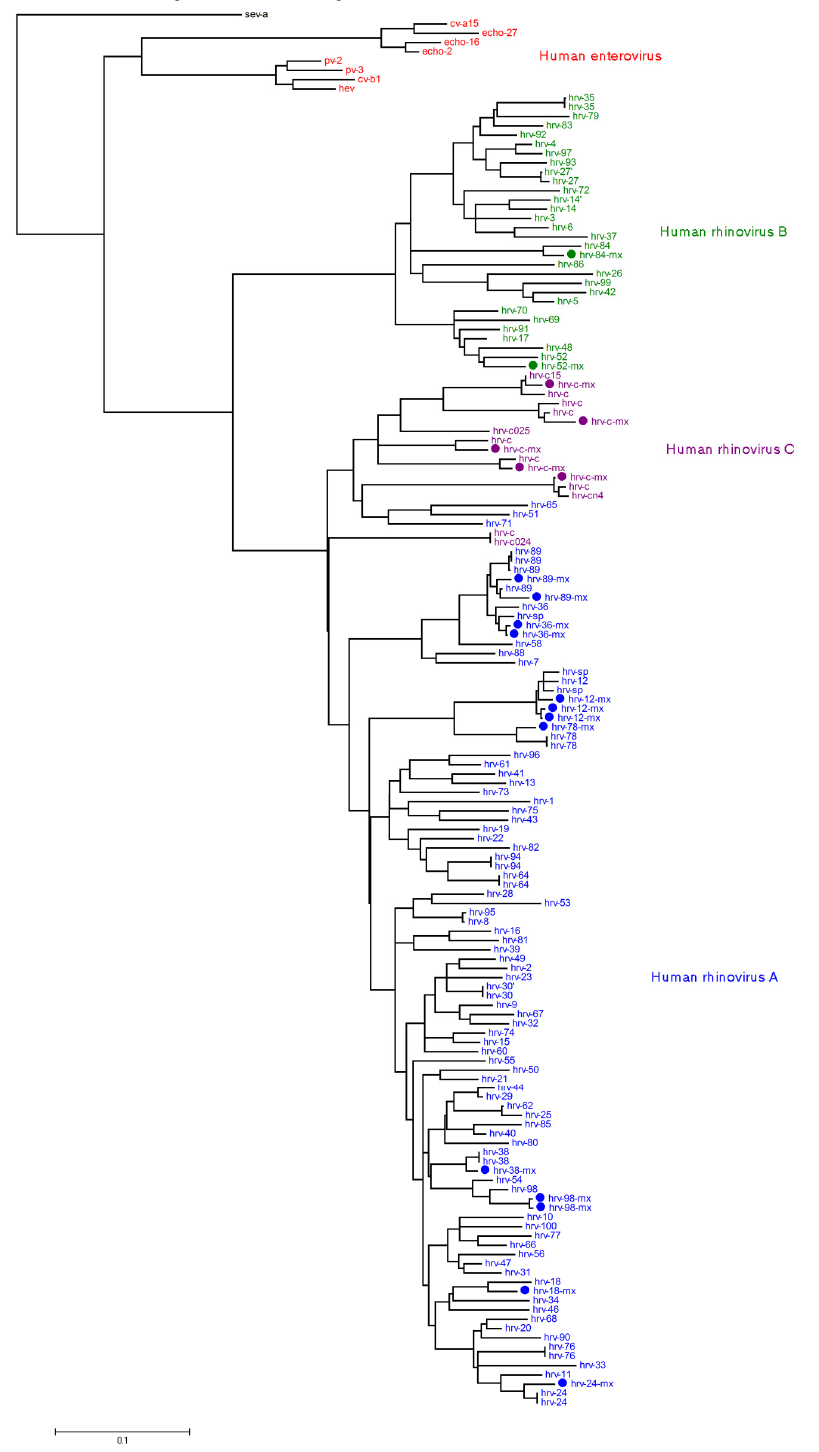
Figure 1. Phylogenetic tree of 5 ′ -nontranslated region (5 ′ -NTR) sequences of human rhinovirus (HRV) from nasal swabs. The phylogenetic tree was constructed by means of the maximum likelihood method. Reference strains of each species obtained from GenBank are indicated, and the species assignment in this study is indicated by circles. Accession numbers are JQ000010 to